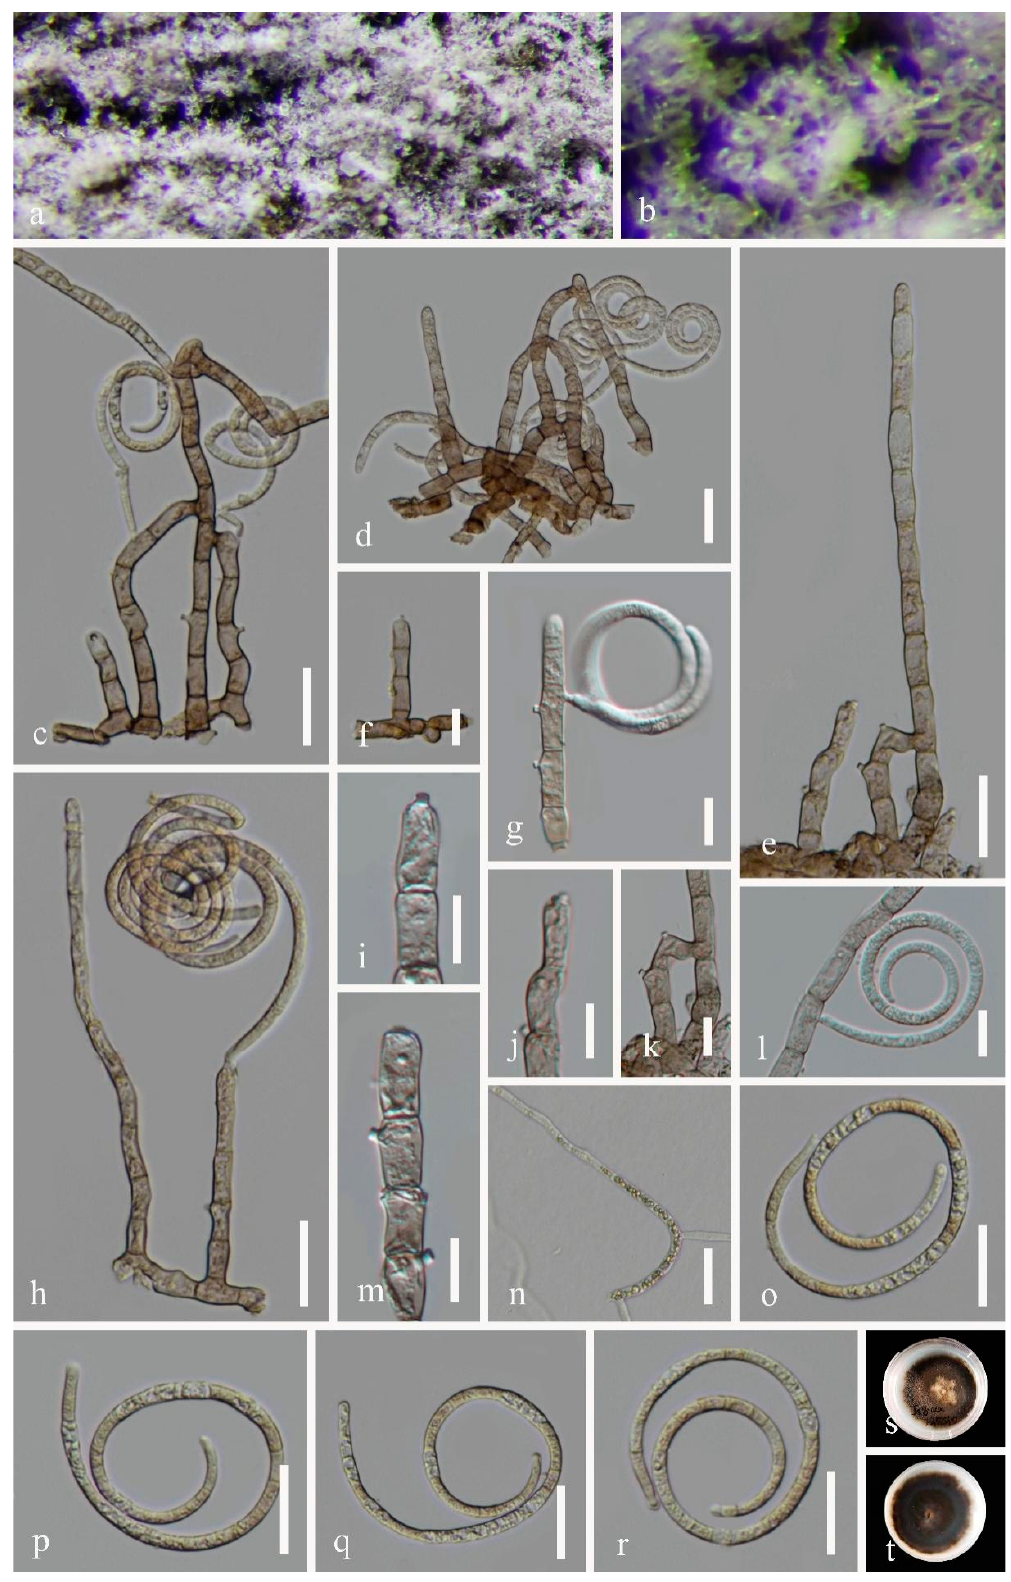
Figure 1. Neohelicosporium griseum (GZAAS 22-2002) ( a , b ) Colonies on natural substrates. ( c – f , h ) Conidiophores and conidia. ( g , i – m ) Conidiogenous cells and conidia. ( o – r ) Conidia. ( n ) Germinated conidium. ( s , t ) Culture on a PDA from above and reverse. Scale bars: ( c – e , h , n – r ) 20 µm, ( f – g , i – m ) 10 µm.